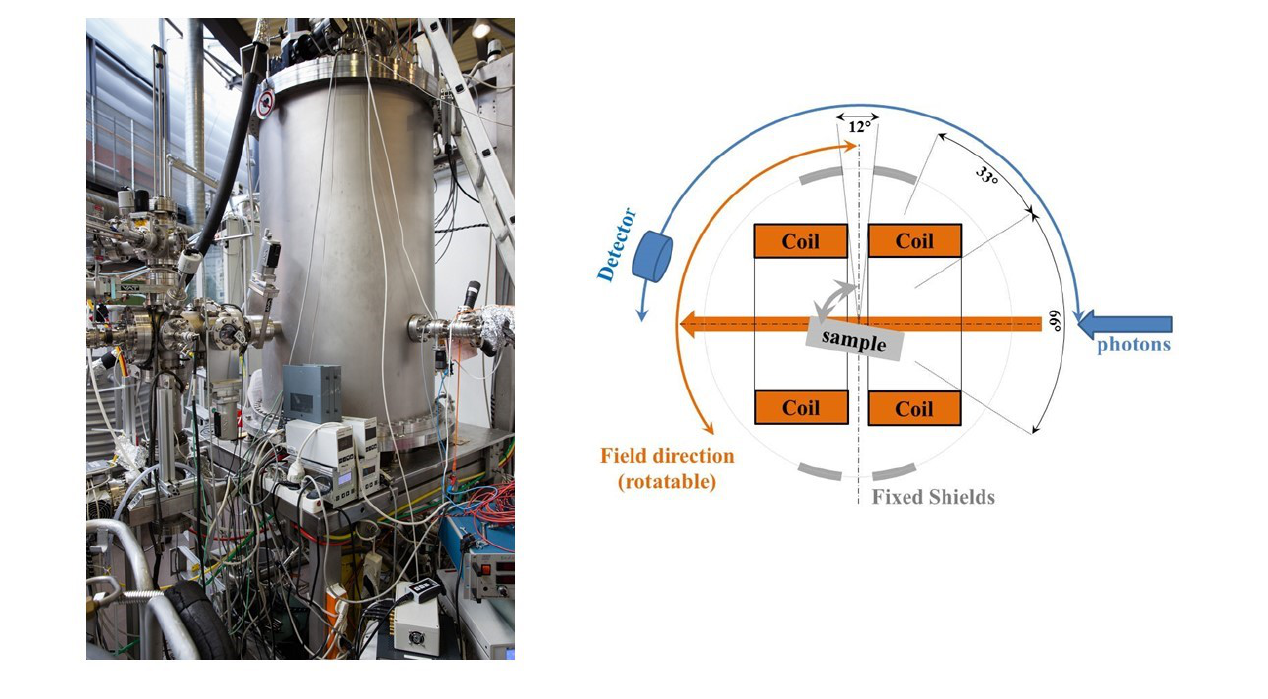
Figure 4: View of the High-Field Diffractometer (left) and schematic representation of the scattering plane